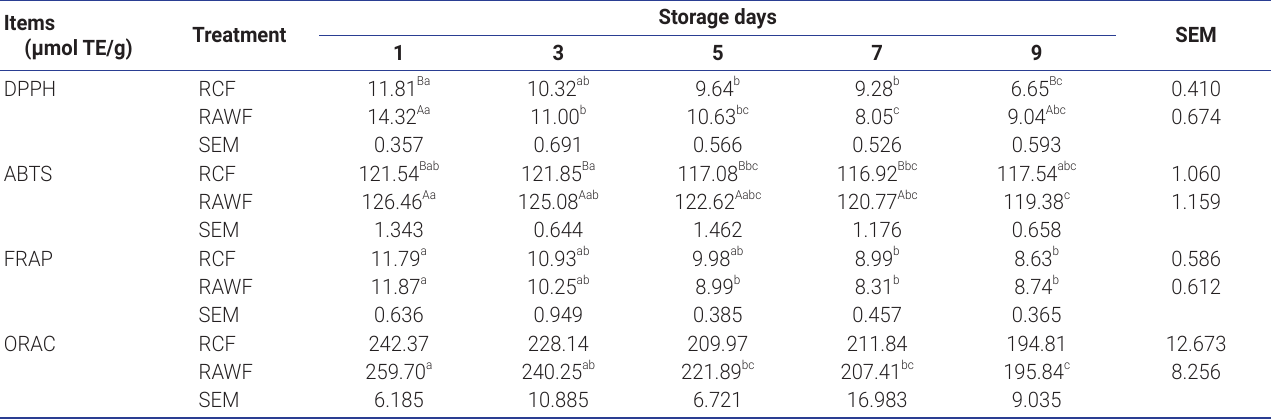
Table 6. Antioxidation activity of thigh meat of Ross 308 broilers from conventional and animal welfare farming system during cold storage Items (μmol TE/g)